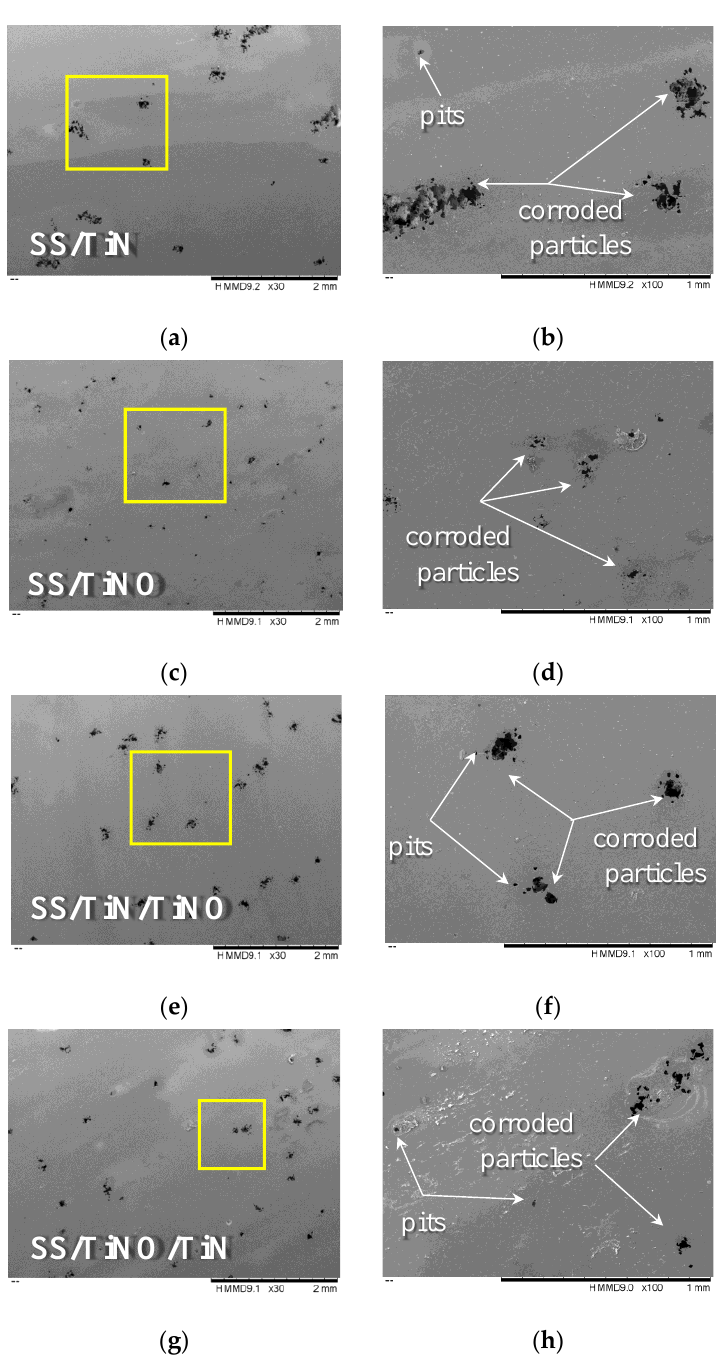
Figure 7. Surface morphology of all coatings at the end of the corrosion tests obtained by SEM: ( a ) SS / TiN coating ( × 30 magnification); ( b ) SS / TiN coating ( × 100 magnification) corresponding to the yellow square in Figure 7a; ( c ) SS / TiNO coating ( × 30 magnification); ( d ) SS / TiNO coating ( × 100 magnification), corresponding to the yellow square in Figure 7c; ( e ) SS / TiN / TiNO coating ( × 30 magnification); ( f ) SS / TiN / TiNO coating ( × 100 magnification) corresponding to the yellow square in Figure 7e; ( g ) SS / TiNO / TiN coating ( × 30 magnification); ( h ) SS / TiNO / TiN coating ( × 100 magnification), corresponding to the yellow square in Figure 7g.